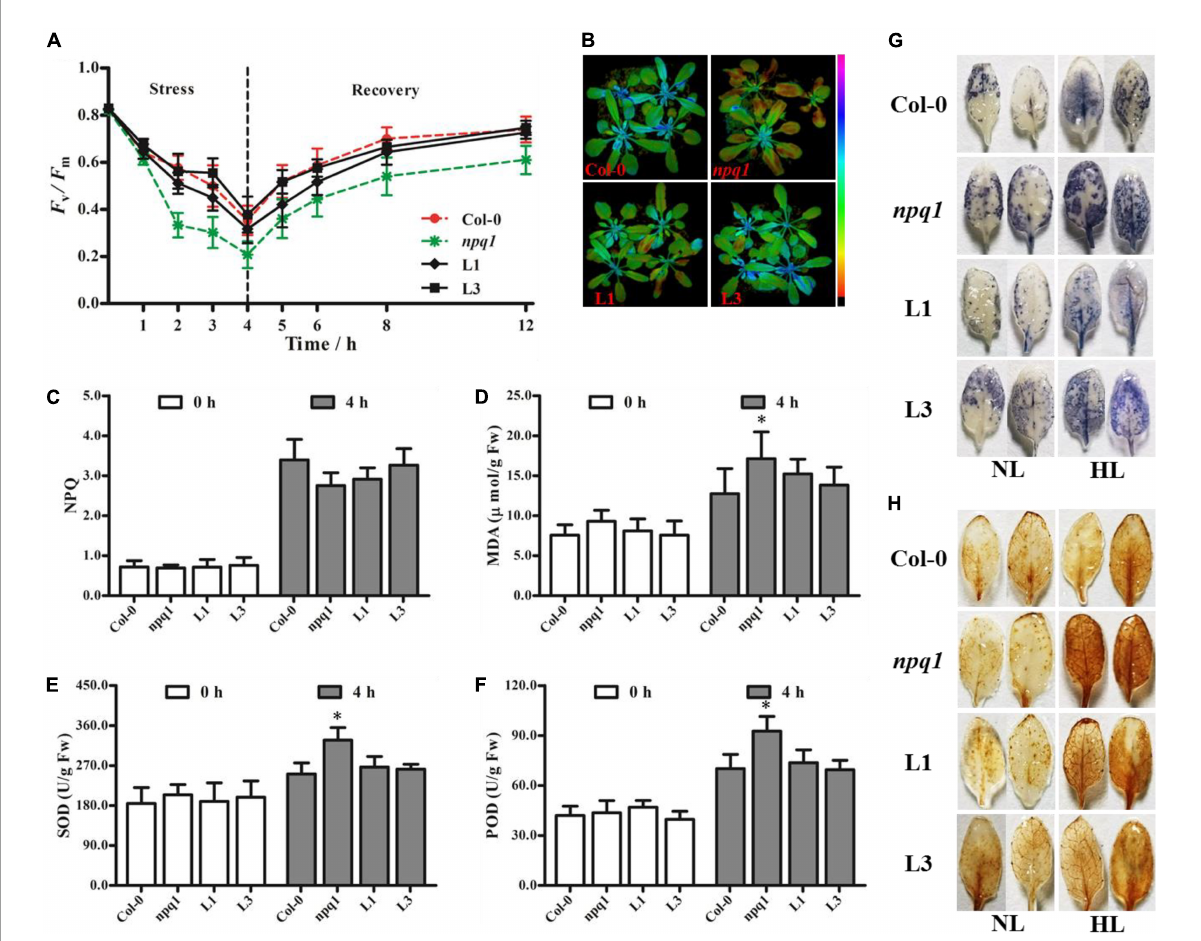
FIGURE6 Overexpression of PeVDE in npq1 mutant confers tolerance to high light intensity. (A) Quantification of F v / F m under high light stress. (B) Chlorophyll fluorescence images of F v / F m . (C) NPQ. (D) MDA content. (E) SOD activity. (F) POD activity. (G) Representative images illustrating O 2 •− accumulation in the leaves of Col-0, npq1 , and transgenic lines were visualized by staining with NBT. (H) Representative images illustrating H 2 O 2 accumulation in the leaves of Col-0, npq1 , and transgenic lines, visualized by staining with DAB. NL, normal light; HL, high light. Asterisks indicate significant differences ( ∗ p <